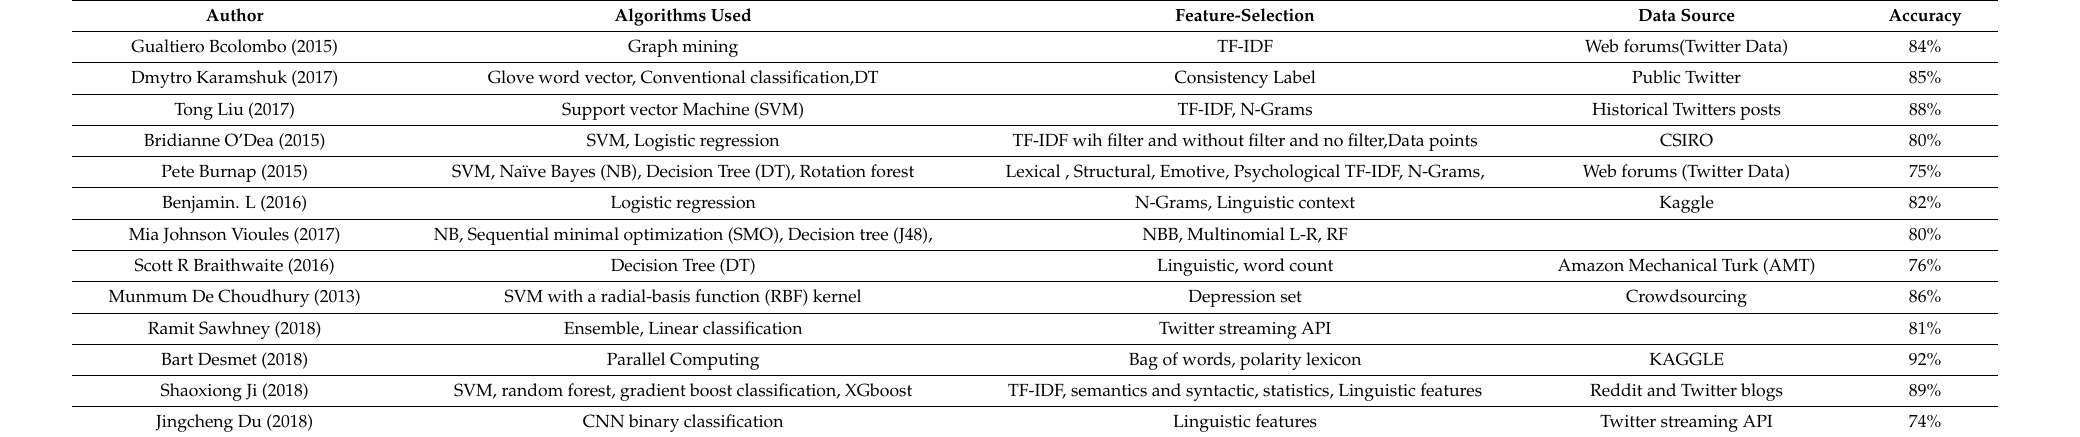
Table 1. Literature